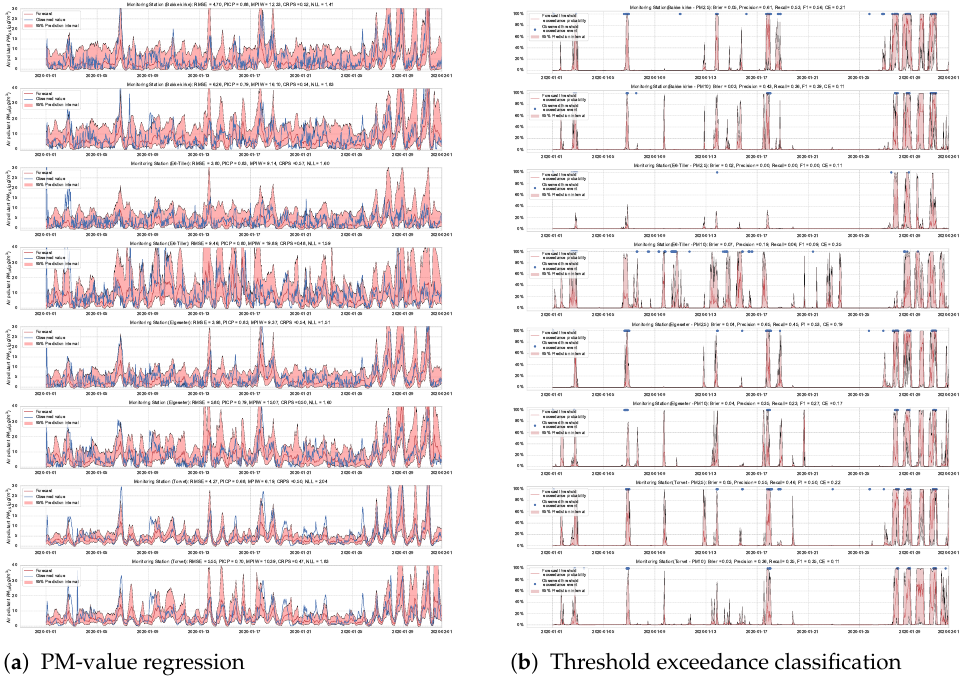
Figure A13. Deep probabilistic forecast of air quality using GNNs with MC dropout at four monitor- ing stations.